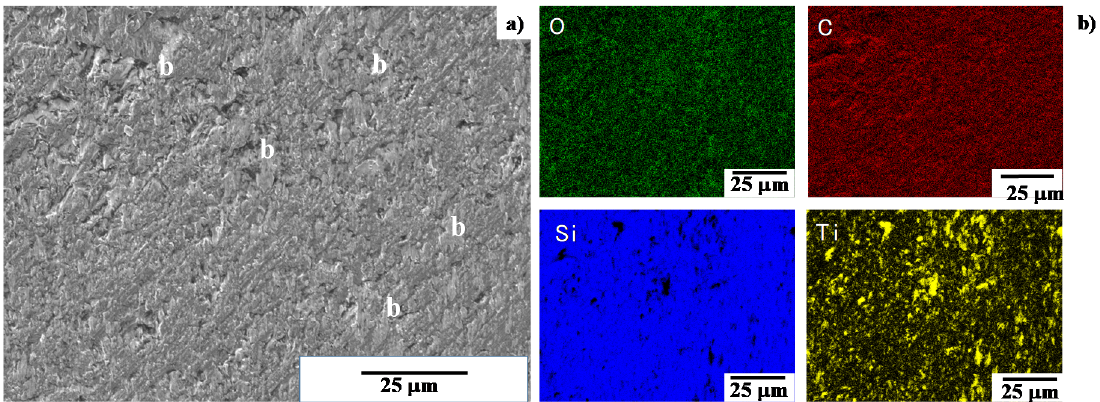
Figure 10. SEM–EDX analyses on the contact interface at the B-region. ( a ) SEM image of the B-region, ( b ) element mapping of oxygen, carbon, silicon and titanium on the A-region.